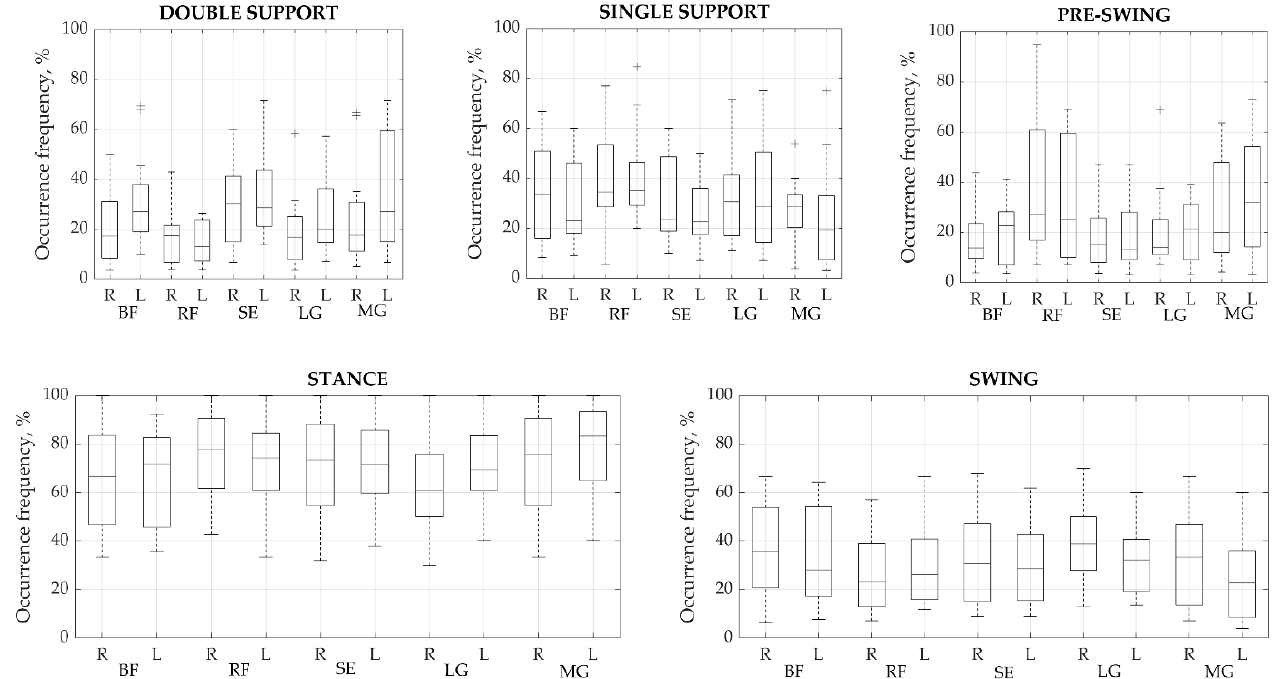
Figure 3. Occurrence frequency of a primary activation modality for each muscle group during each phase (%). Values presented as means ± SD. BF—biceps femoris, RF—rectus femoris, SE—semitendinosus, LG—lateral gastrocnemius, and MG—medial gastrocnemius. R—right, L—left side. Table 5. Time parameters for primary activation of each muscle in each gait phase. Time Muscle Inst.